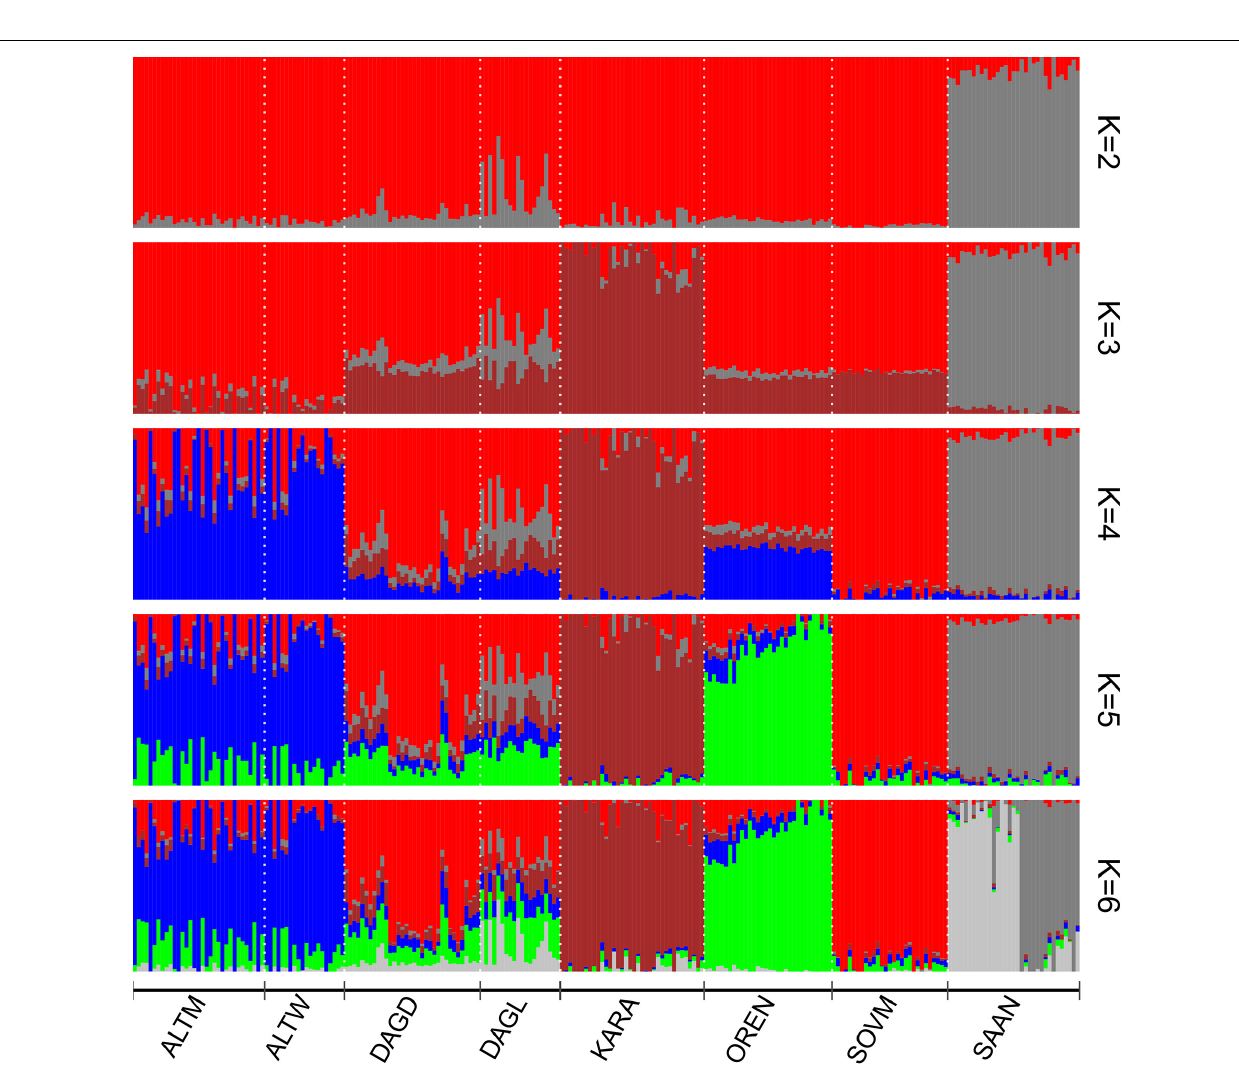
FIGURE 4 | Population structure of Russian goat populations. For a description of the goat breeds, see Table 1